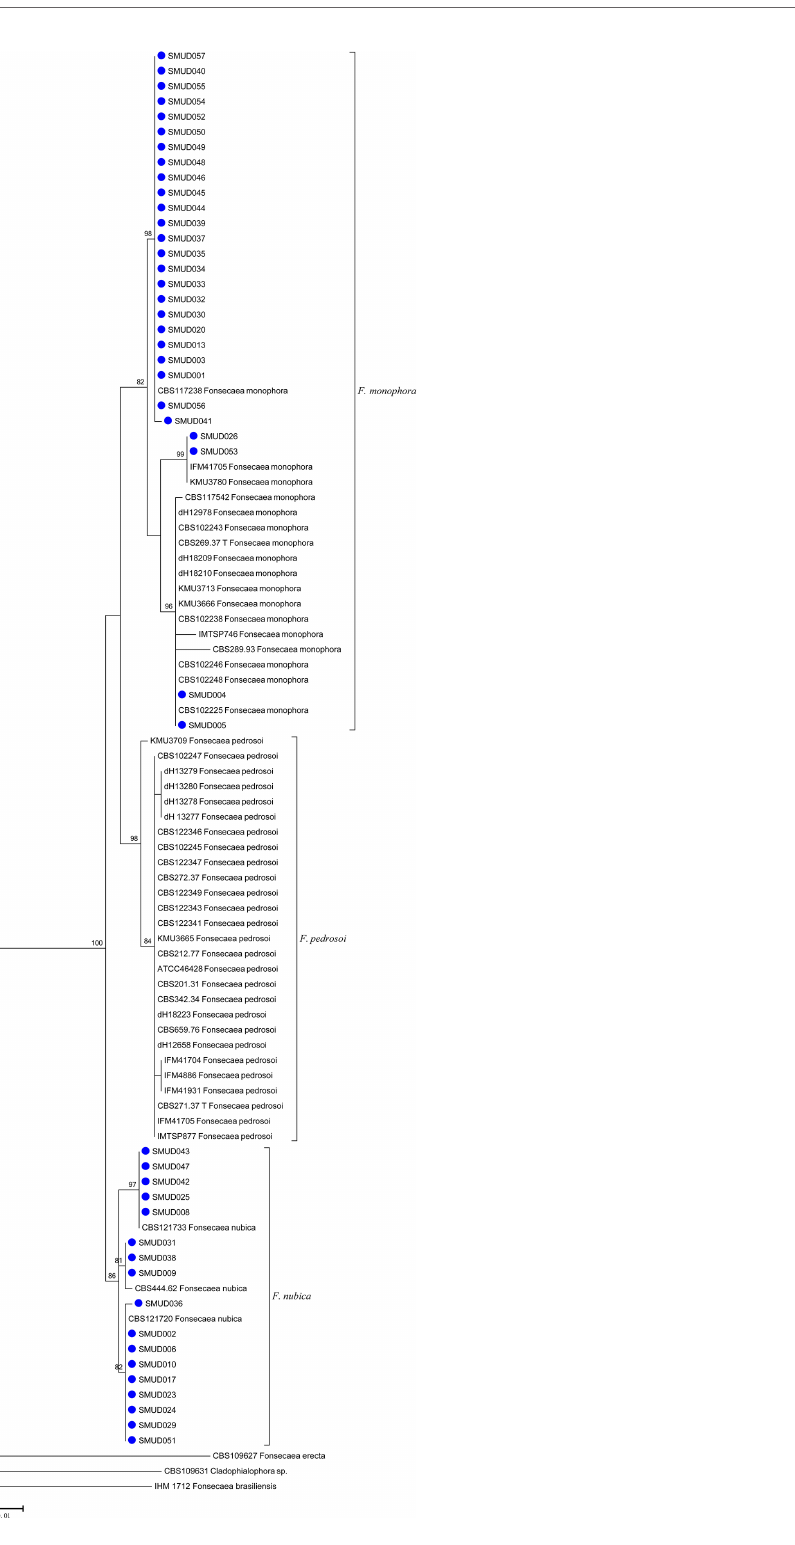
FIGURE 1 | An ITS maximum likelihood (ML) phylogenetic tree of strains isolated in this study. Three species, F. monophora , F. pedrosoi , and F. nubica , were shown in the tree. The tree was constructed with MEGA 6.0 using K2+G model with 500 bootstrap replicates. Bootstrap > 70 were considered as consistent support branches. The strains in this study were marked as a blue dot in